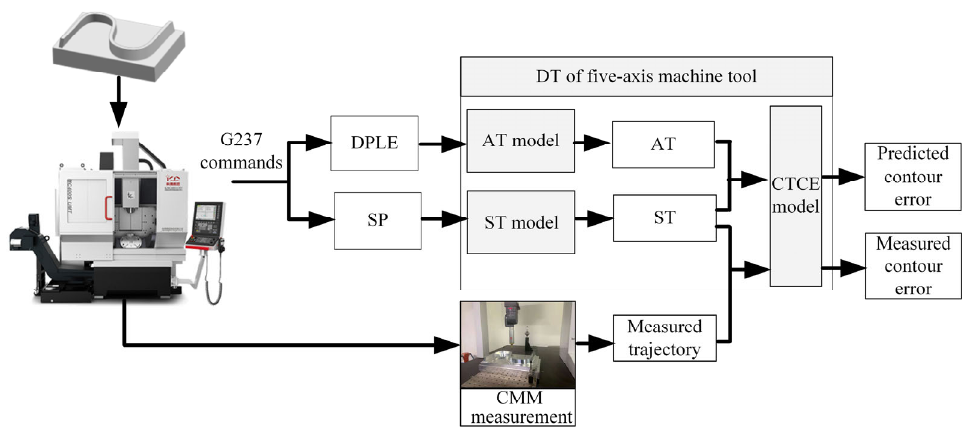
Figure 14. Contour error prediction process of S ‐ shaped trajectory.